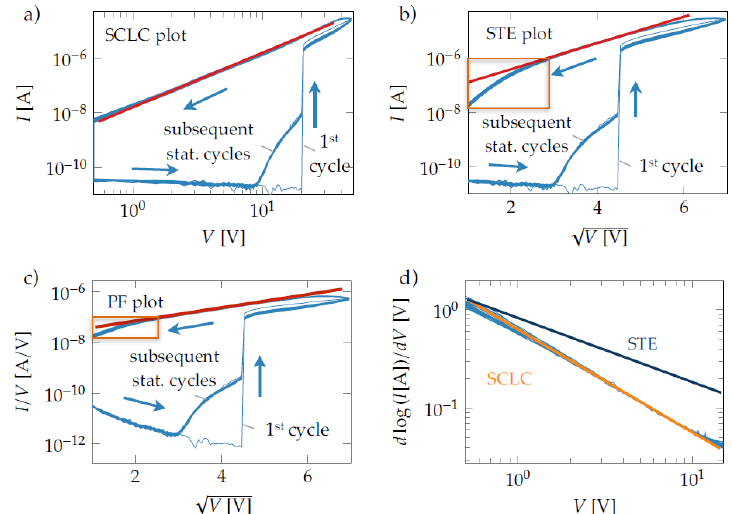
Figure 4. Conductance type analysis on CDWs in LNO ( a ) SCLC I–V plot; ( b ) STE I–V plot; ( c ) PF I–V plot; ( d ) derivative plot. The I–V curves show the first cycle and the stationary cycles after 20 cycles. The off-state was obtained by applying V = −210 V until the current is reduced to 10 −8 A.